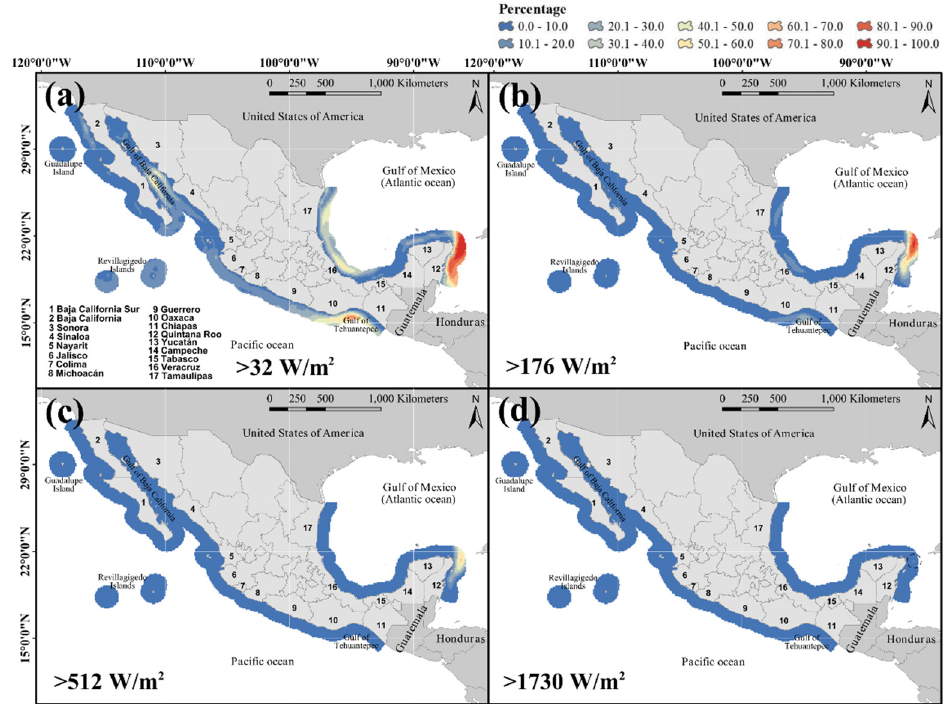
Figure 2. Theoretical ocean current power availability in Mexico, considering five-year data, showing the percentage of time over the five-year period for different thresholds of power: ( a ) 32 W/m 2 , ( b ) 176 W/m 2 ; ( c ) 512 W/m 2 , and ( d ) 1730 W/m 2 .